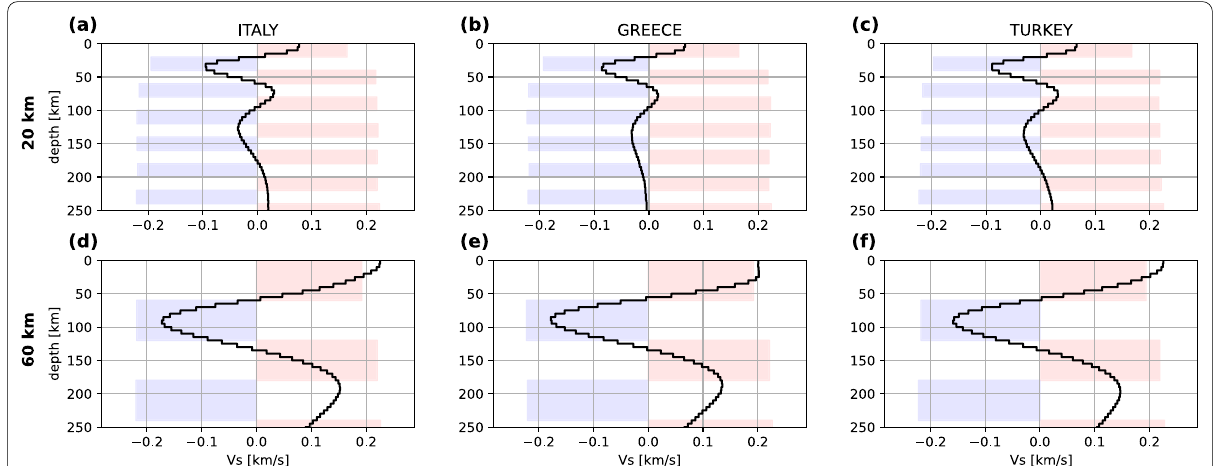
Fig. 8 Examples of checkerboard test of the inverted model for the GWR C021 superconducting gravimeter (Membach) for three regions: Italy ( a , d ), Greece b , e and Western Turkey ( c , f ); positive/negative anomalies thicknesses equal to 20 km a – c and 60 km d – f (red/blue shaded areas) together with recovered anomalies (black solid